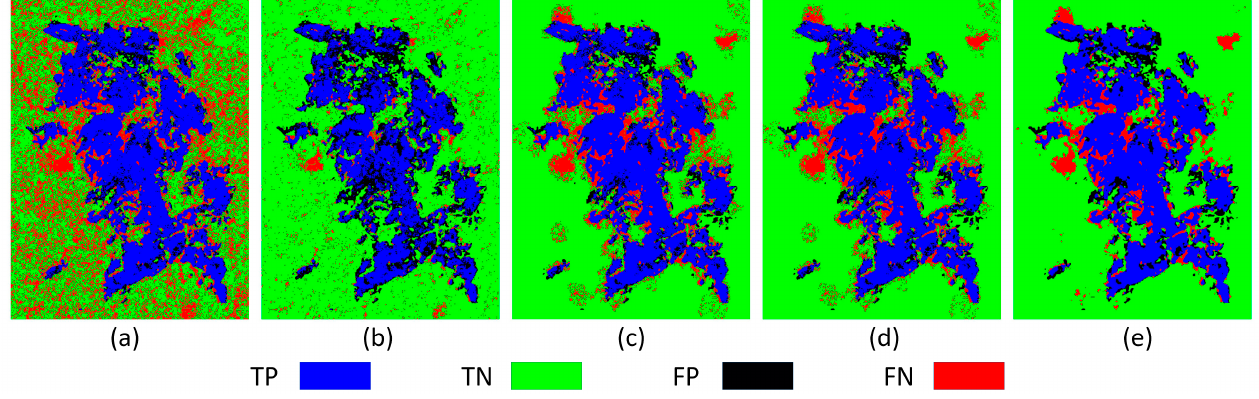
Figure 8. Confusion image of ( a ) FCM, ( b ) FCM ‐ DCNN, ( c ) SG ‐ FCM ‐ SVM, ( d ) SG ‐ FCM ‐ DNN, and ( e ) SG ‐ FCM ‐ DCNN.